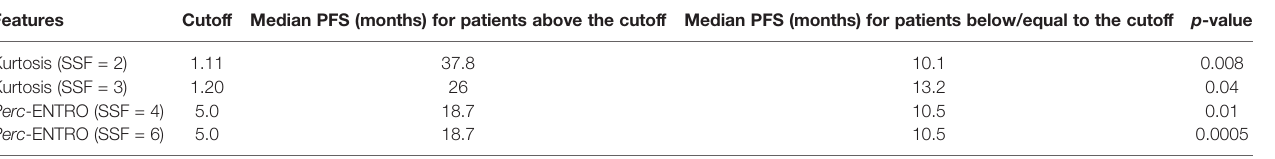
TABLE 5 | Kaplan – Meier analysis for signi fi cant texture predictors of PFS. Features